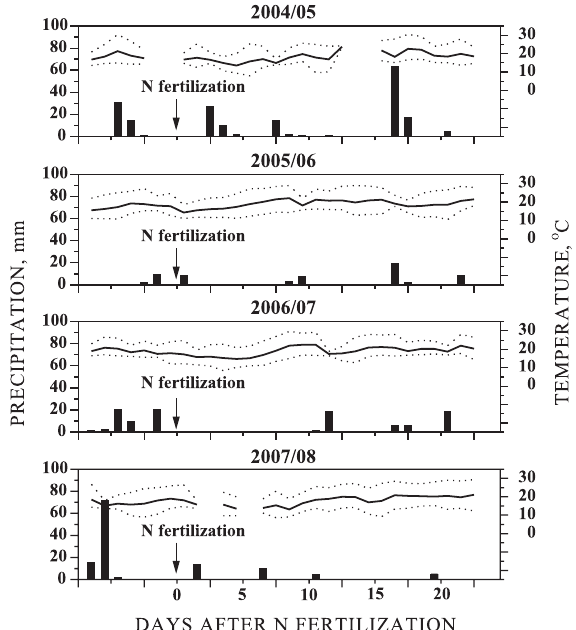
Figure 1. Pluviometric precipitation (vertical bars) and air temperature (minimum, average and maximum) for the month of November during four growing seasons in Guarapuava,